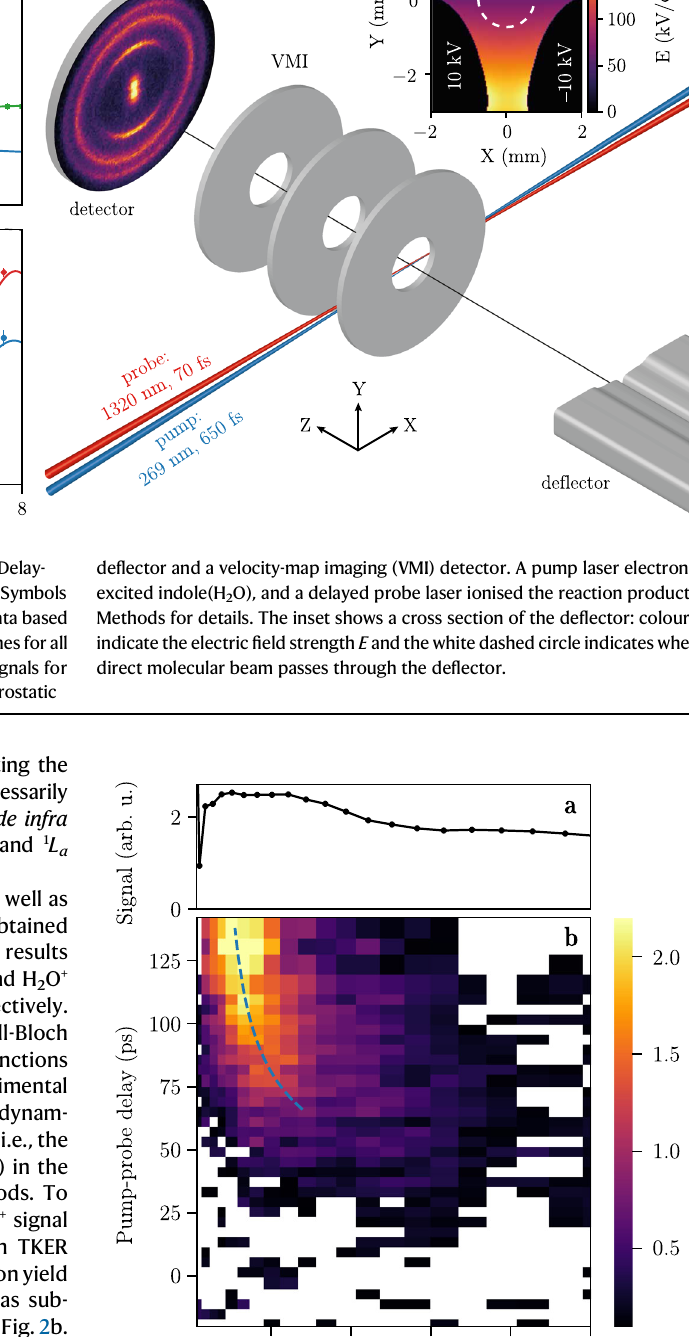
Fig. 2 | Time evolution of the total kinetic-energy release distribution of H 2 O + . a Totalkinetic-energy release (TKER)distribution for negative pump-probe delays, based on the projected kinetic-energy distribution of H 2 O + . b Time-dependent TKER-distribution differences from the neutral dissociation of indole(H 2 O) after subtraction of the delay-independent signal. The blue dashed line represents the mean TKER obtained from an ion-dipole-interaction model, see Methods.